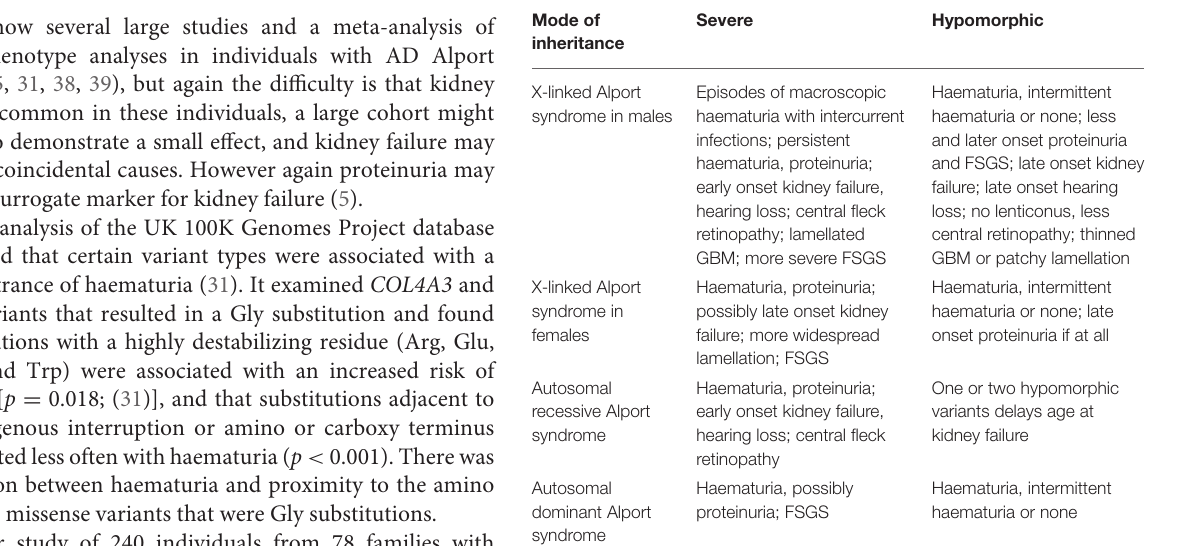
TABLE 2 | Clinical phenotype of severe and hypomorphic